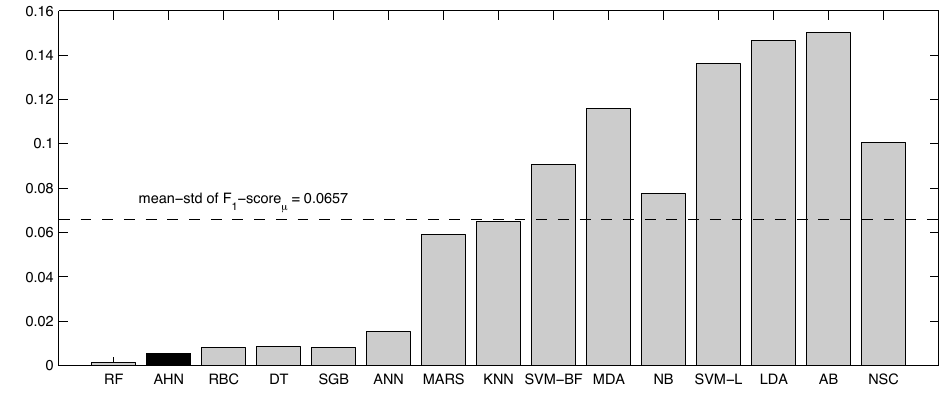
Figure 8. Overall variability of supervised classifiers present in the experiments with respect to the F 1 -score µ metric.